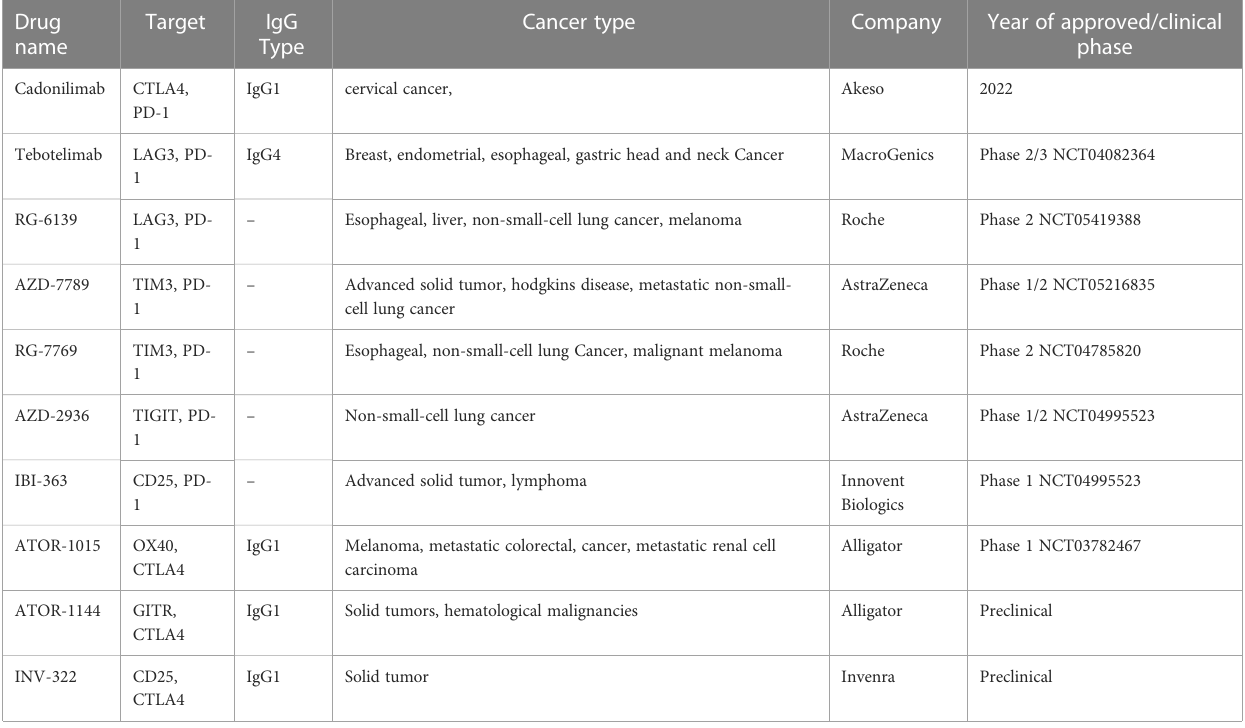
TABLE 2 Next-generation bispeci fi c antibodies targeting Tregs in tumor